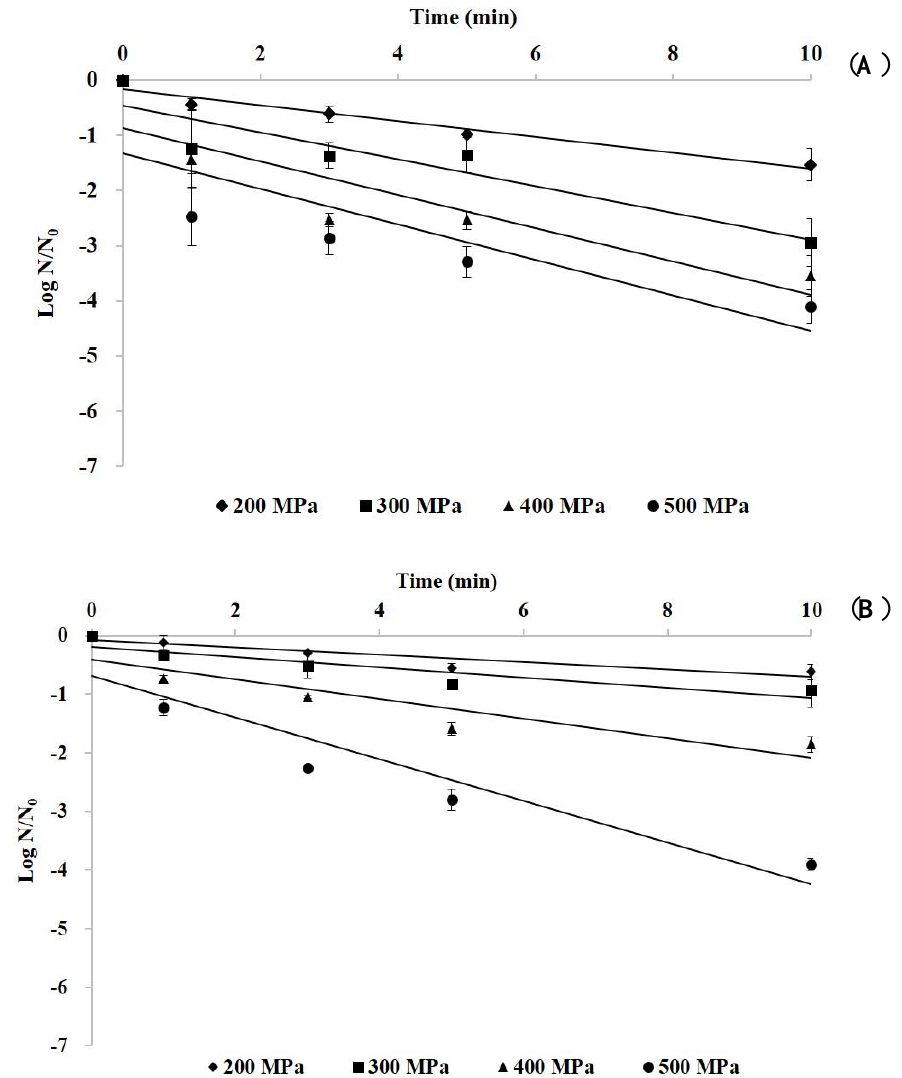
Figure 3. The survival curves of E. aerogenes ( A ) and S. capitis ( B ) in marlin meat slurry by HHP treatment at 200–500 MPa for up to 10 min.